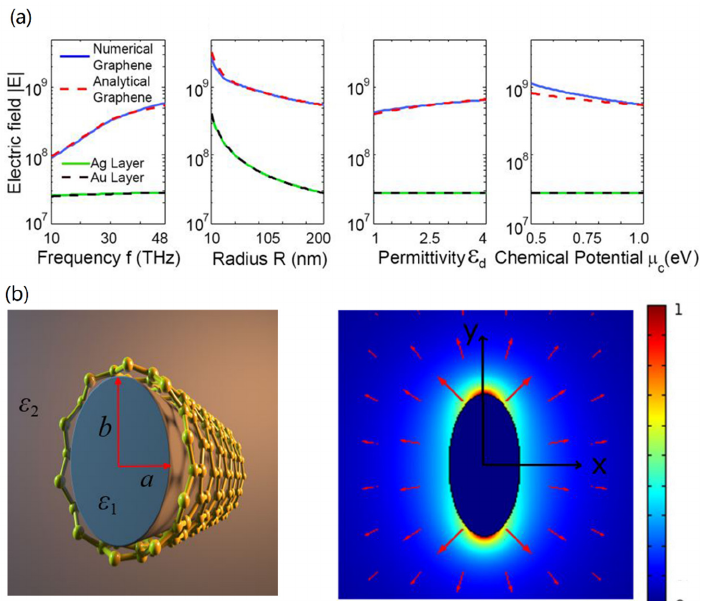
Figure 4. ( a ) The electric fields | E | of the graphene-coated and metal-coated nanowire waveguides as functions of frequency, nanowire radius R , nanowire permittivity, and chemical potential. Reprinted with permission from reference [49]. Copyright Optical Society of America, 2014. ( b ) Graphene-coated elliptical nanowire and normalized electric field distribution